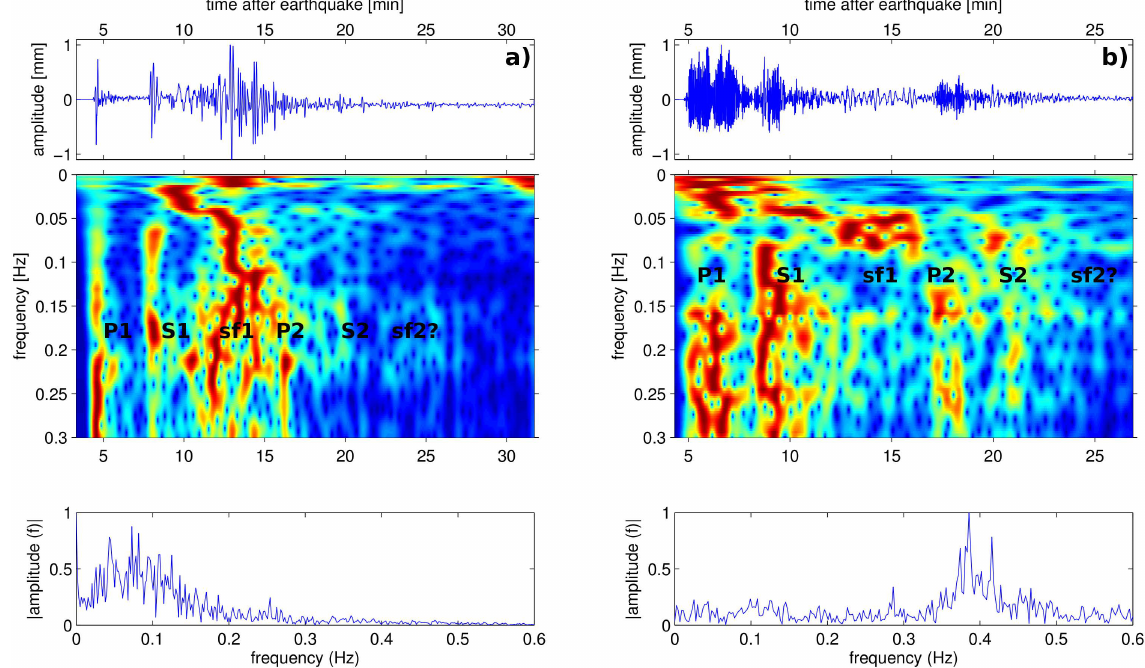
Figure 9. Digitized waveform (upper part), time–frequency spectra (middle part) and frequency–amplitude spectra (lower part) of digitized unfiltered waveforms of (a) the Z component of a 1300kg Wiechert seismograph at station GTT and (b) an undamped vertical pendulum at station EBR. Both digitized seismograms clearly show P and S phases and dispersed surface waves from the first earthquake, whereas the body phase arrivals from the second earthquake can only be identified in the time–frequency spectrogram. The absence of surface waves in both recordings from the second earthquake indicates a large hypocentral